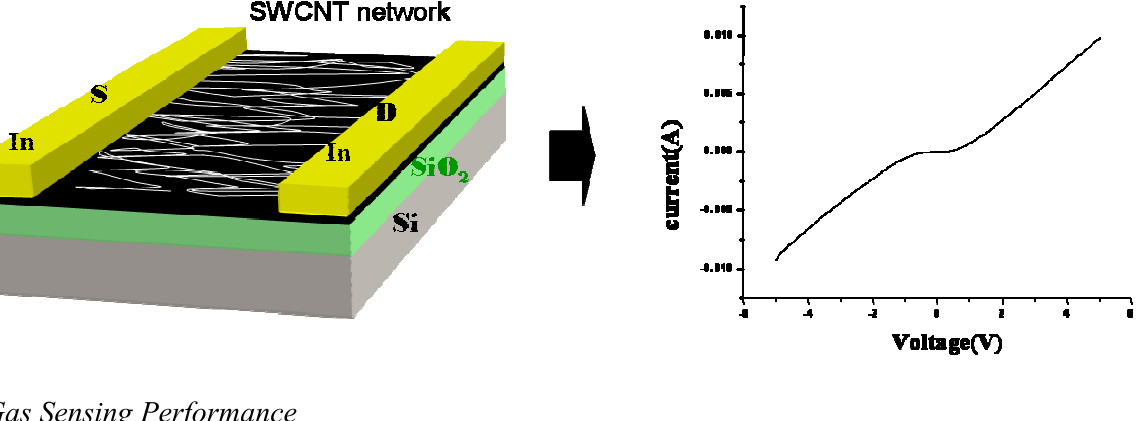
Figure 5. Schematic diagram and I-V curve of the gas sensing